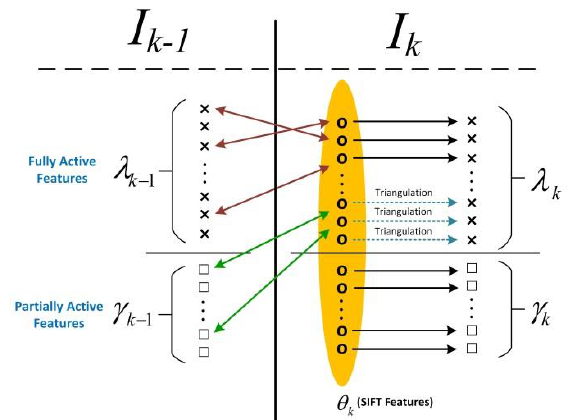
Figure 5. Overall scheme of adopted strategy followed to manage fully and partially active